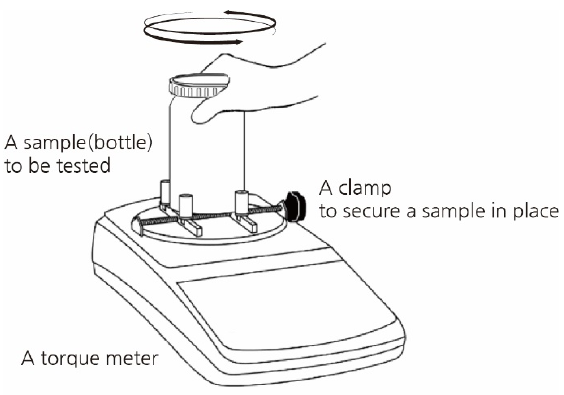
Figure 1. A setting for one-handed opening test with a torque metre in existing studies.